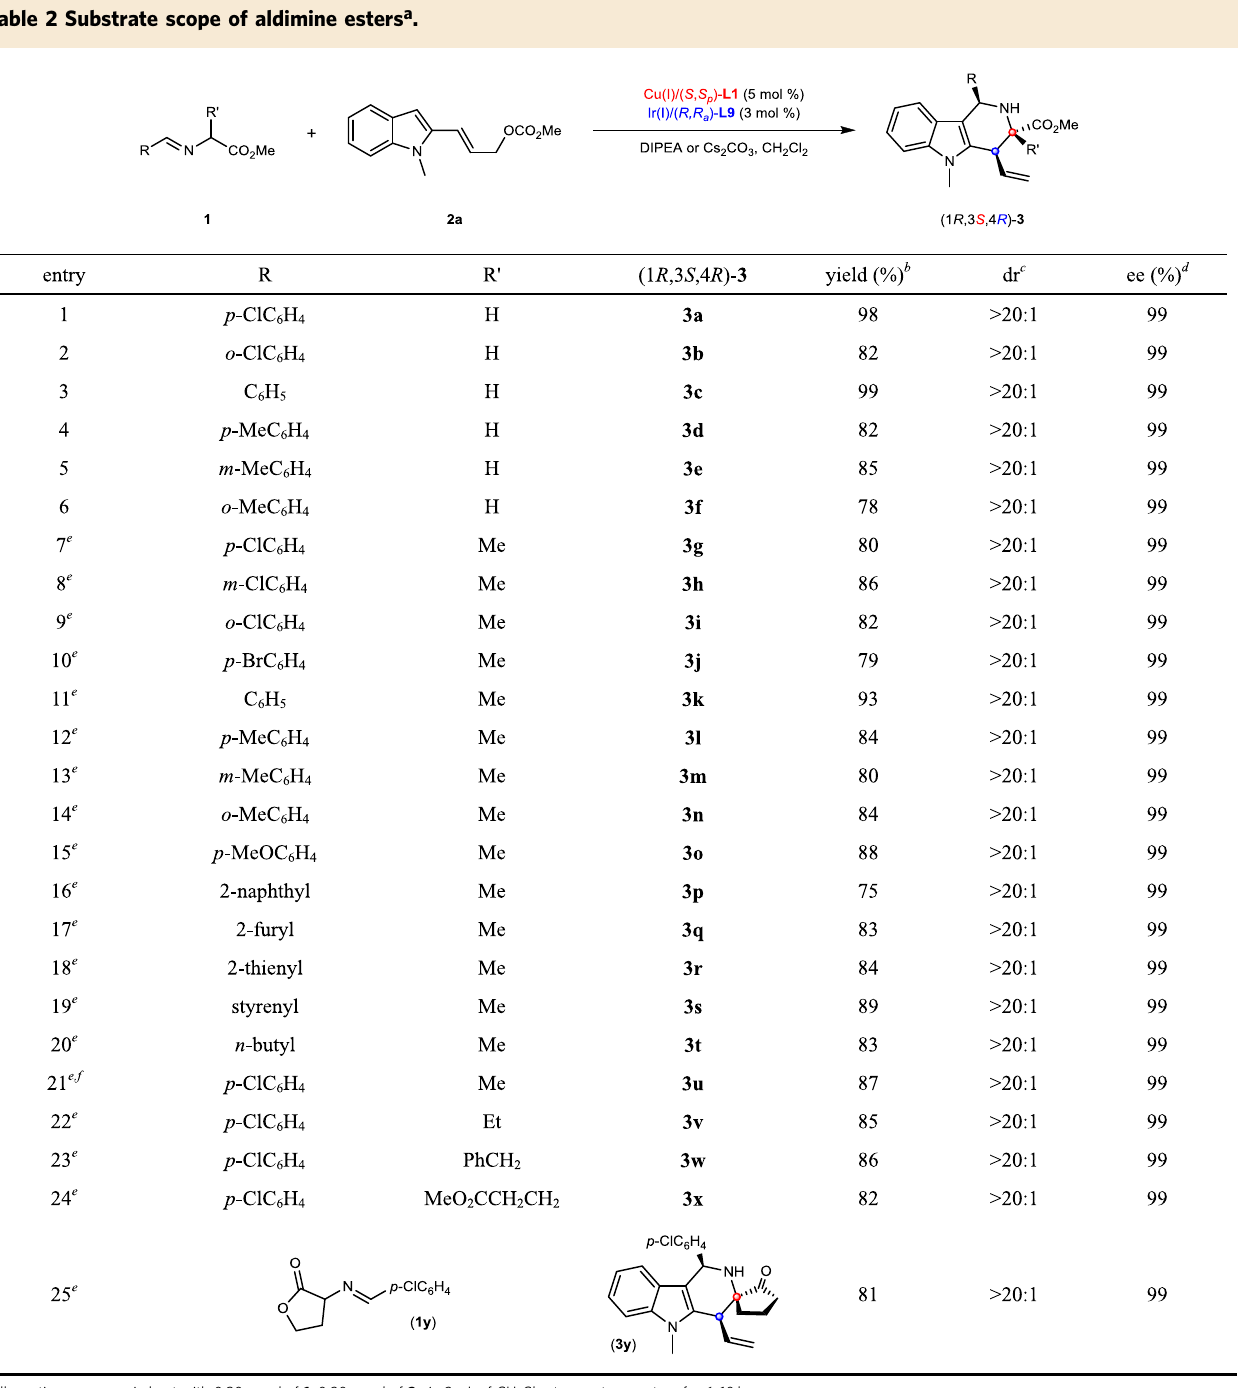
Table 2 Substrate scope of aldimine esters a